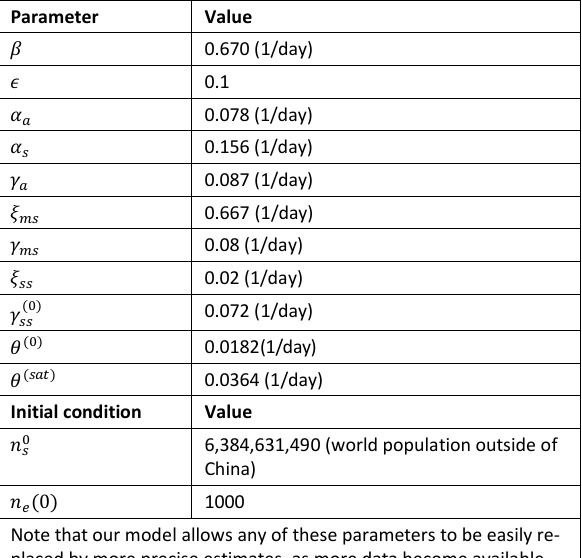
Table 3: List of estimated parameters and initial values. Parameter